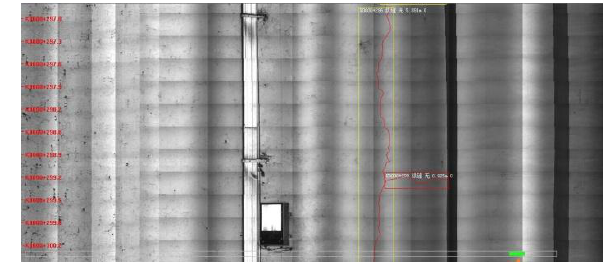
Figure 5 Mosaicked Image Profiles Test Results